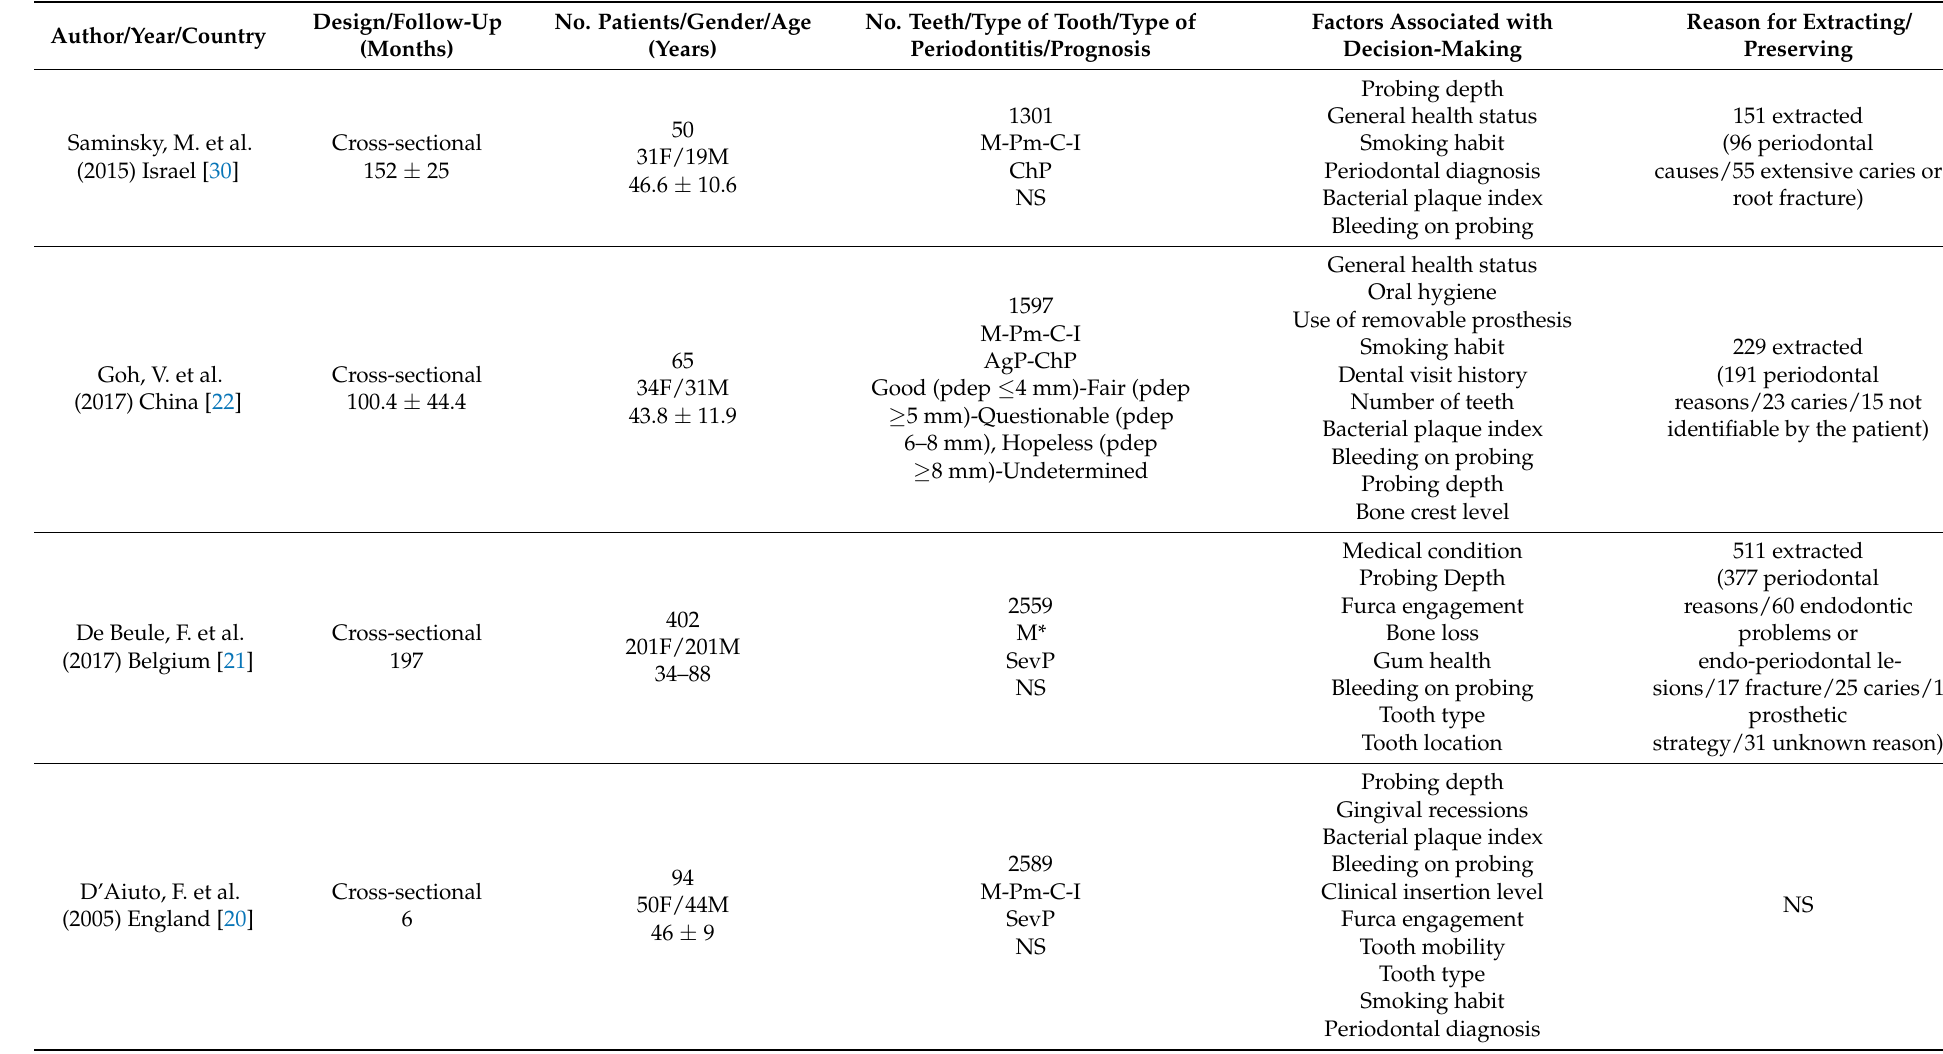
Table 1. Summary of observational studies